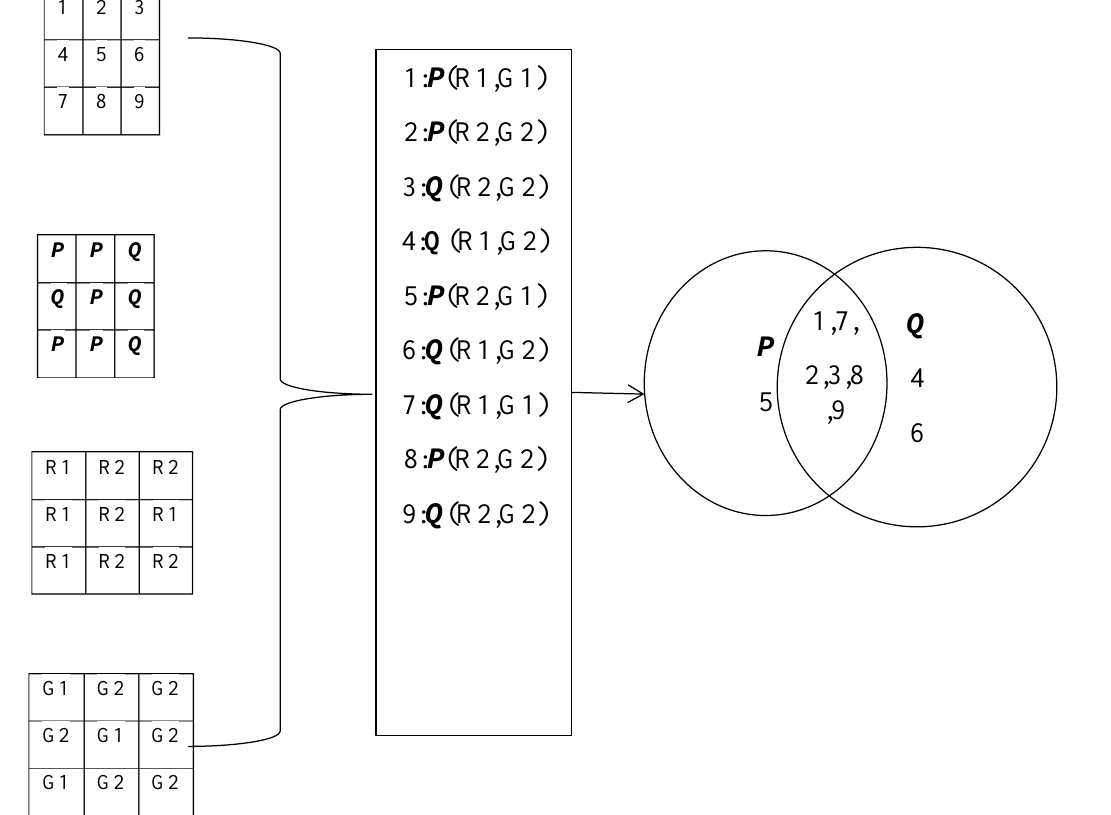
Figure 1. Spatial entity set distance solution process